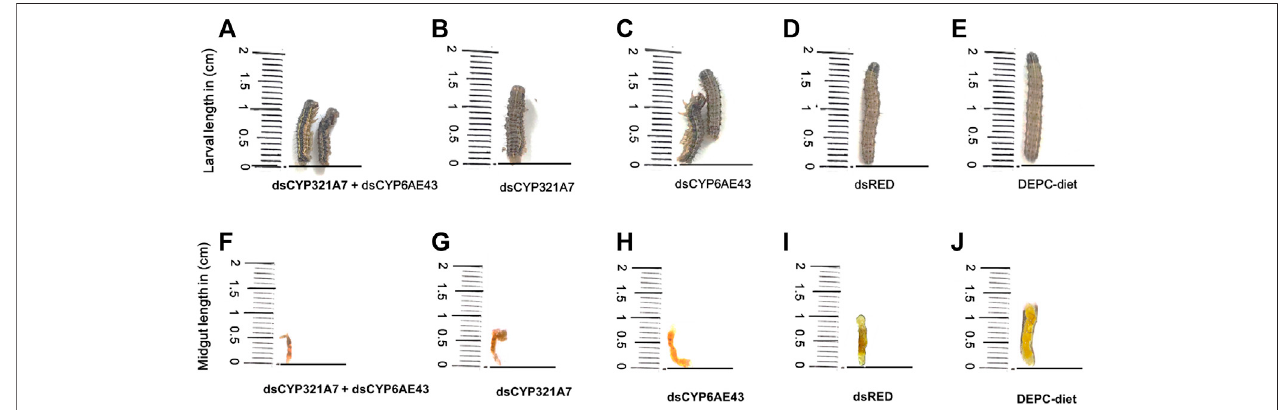
FIGURE 7 | The effect of dsCYP321A7+dsCYP6AE43, dsCYP321A7, dsCYP6AE43, dsRED on the S. frugiperda larvae physiology and growth (Indox-SEL population) after feedingon dsRNAs, or thedsRED asacontrol for24 h followed byexposuretodietsupplemented withLC 20 : 6.84 μ g g − 1 concentration ofindoxacarb for 72 h (A,B,C,D) . DEPC-Diet as a control (Indox-UNSEL population) without exposure to indoxacarb (E) . Similarly, the effect of dsCYP321A7+dsCYP6AE43, dsCYP321A7, dsCYP6AE43 and dsRED on the midguts physiology of S. frugiperda larvae (Indox-SEL population) after feeding on dsRNAs, or the dsRED as a controlfor24 hfollowedbyexposuretodietsupplementedwithLC 20 :6.84 μ g g − 1 concentrationofindoxacarbfor72 h (F,G,H,I) .DEPC-Dietasacontrol(Indox-UNSEL population) without exposure to indoxacarb (J)